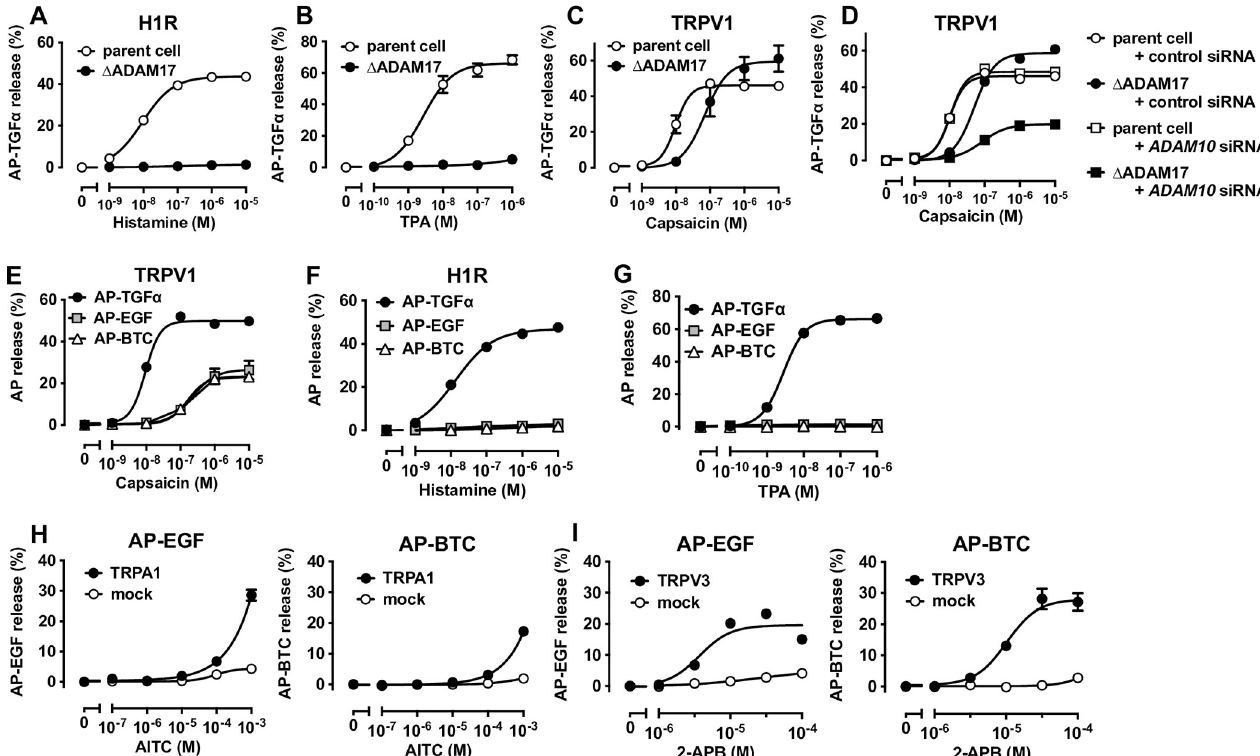
Fig 2. TRP channel activation induces ectodomain shedding of EGFR ligands via both ADAM10 and ADAM17. (A–C) Concentration–response curves showing the TGF α -shedding response in ADAM17-deficient HEK293 cells ( Δ ADAM17 cells). H1R (A) and TRPV1 (C) were evaluated as representatives of Gq-coupled GPCRs and TRP channels, respectively. TPA-induced shedding responses (B) were evaluated in cells expressing only AP-TGF α without receptors. (D) Concentration–response curve of TGF α -shedding responses induced by TRPV1 activation in ADAM10-siRNA-transfected parent cells or Δ ADAM17 cells. (E–G) Comparisons of shedding responses induced by TRPV1 (E) and H1R (F) activation using AP-EGF and AP-BTC as reporters. The TPA-induced shedding response (G) was evaluated in cells expressing only AP-TGF α , AP-EGF, or AP-BTC, without receptors. (H, I) Concentration–response curves for the EGF- and BTC-shedding responses induced by TRPA1 (H) and TRPV3 (I) activation. In all figures, the symbols and error bars represent the mean and SEM, respectively, for three independent experiments performed in triplicate. For many data points, the vertical error bars are smaller than the symbols and, thus, are not